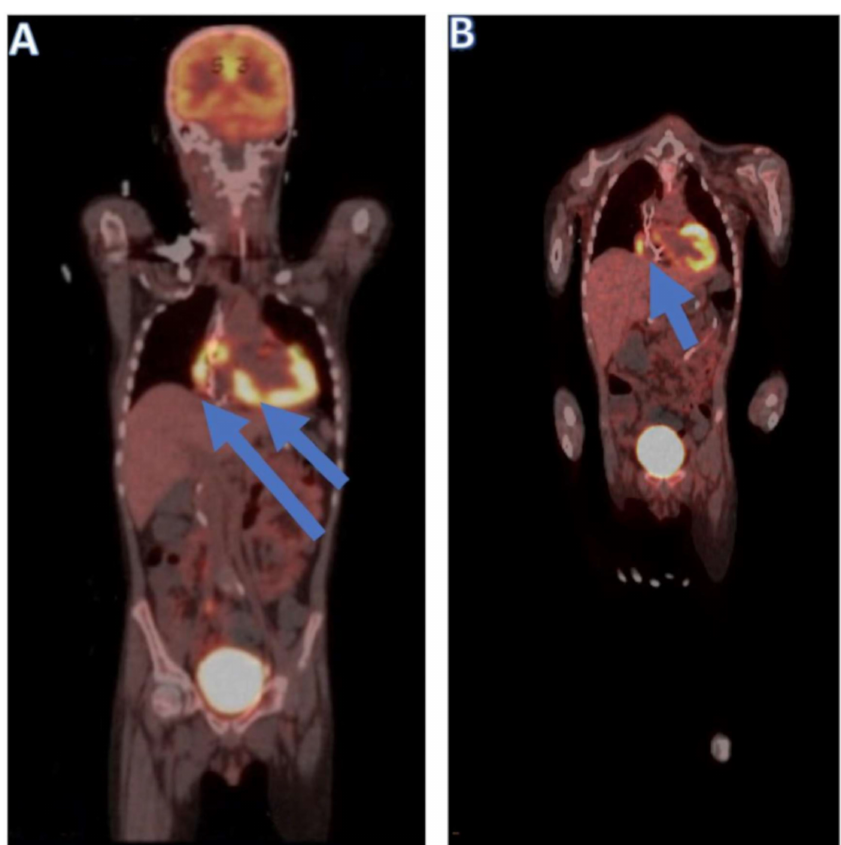
Figure 4. PET scans of the patient showing 18 F-fluorodeoxyglucose uptake in the myocardium involving the right and left ventricles. ( A ) The arrows indicate abnormal uptake in the myocardium involving both ventricles, with a maximum standard uptake value of 15. This uptake is not a typical finding as leukemia in consideration of the high metabolic activity of the lesions. ( B ) The arrows indicate persistent hypermetabolism involving the myocardium predominantly in the lateral wall of the right atrium, the right ventricle, and into the ventricle septum, with a maximum standard uptake value of